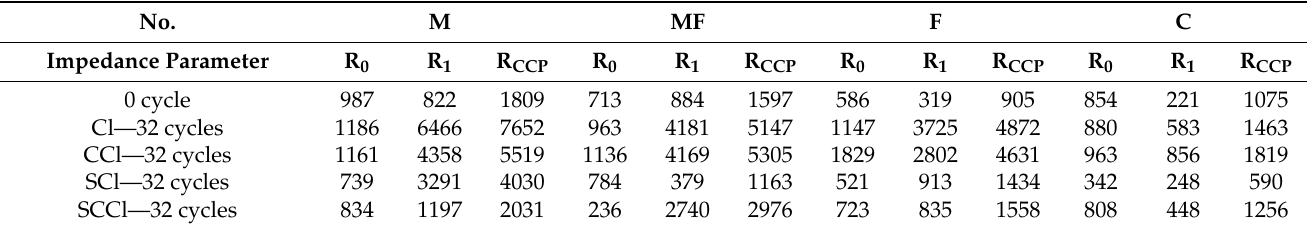
Table 4. AC impedance parameters ( Ω